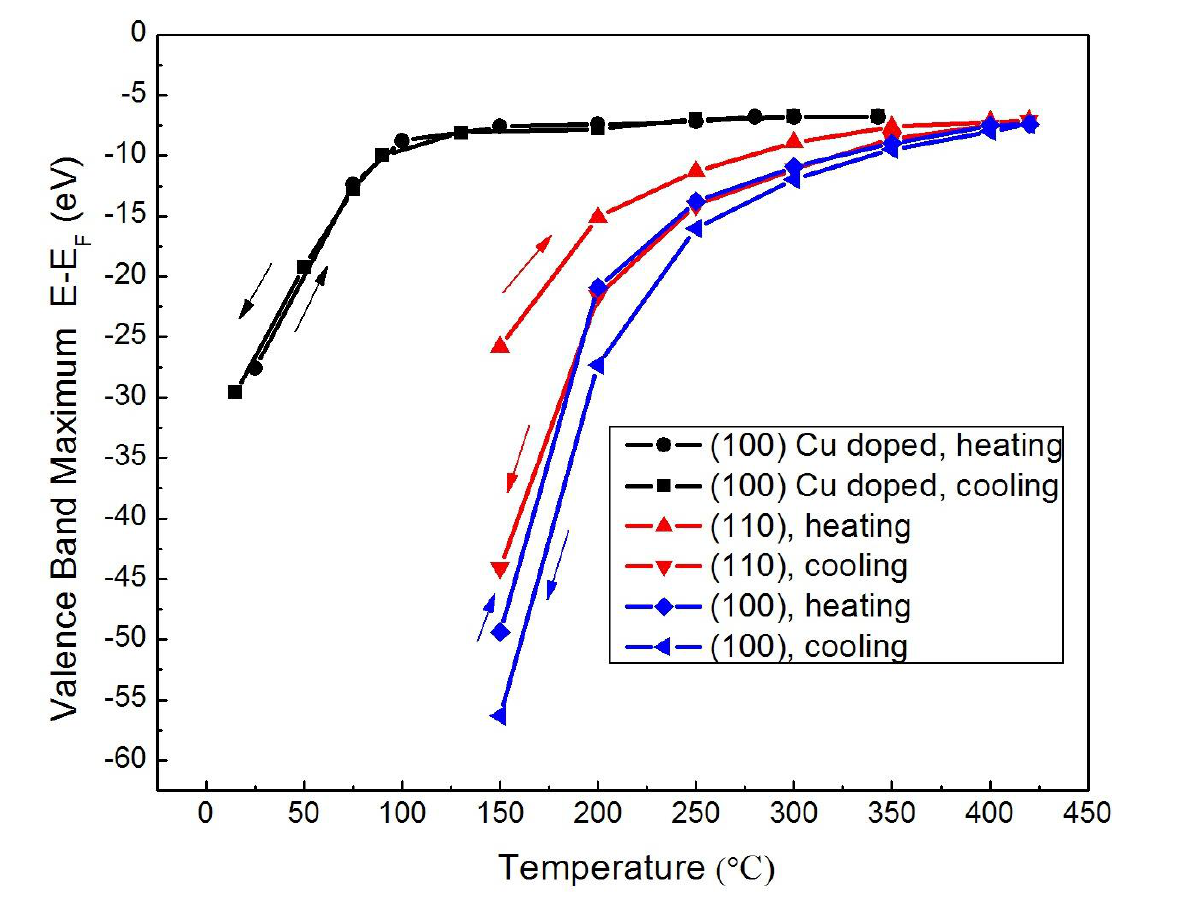
B O (100) or Li 2 4 7